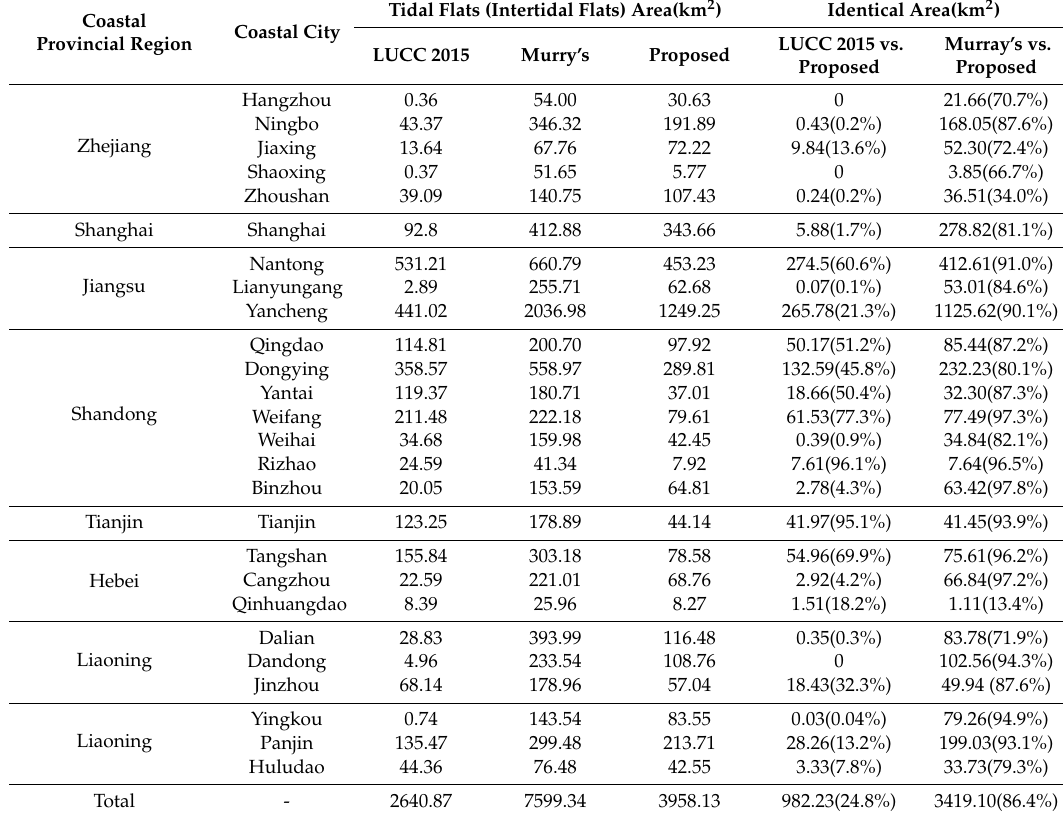
Table 4. Statistical table for tidal flats area of administrative regions in the study area, derived from remote-sensing monitoring data of land use in China (LUCC 2015), Murray’s and ours, respectively. Numbers in round brackets are the proportion of identical area to the intertidal flats area derived from our map. “Proposed” means the resultant tidal flat map in this